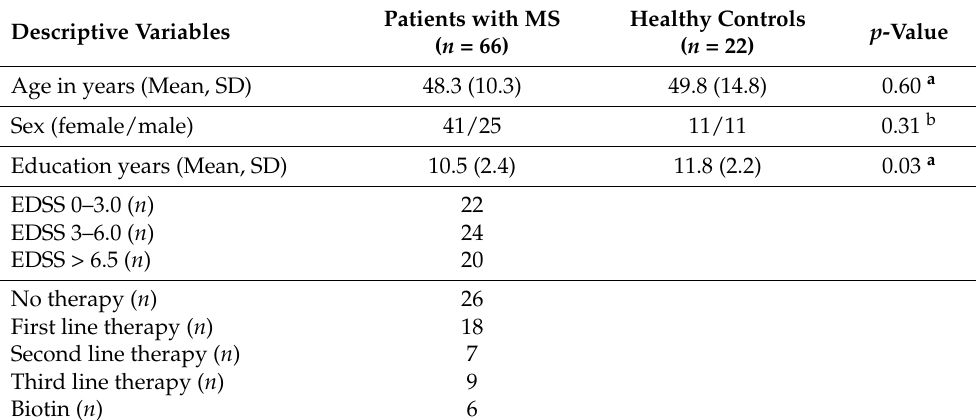
Table 1. Demographics and clinical characteristics of both groups (MS; healthy controls).